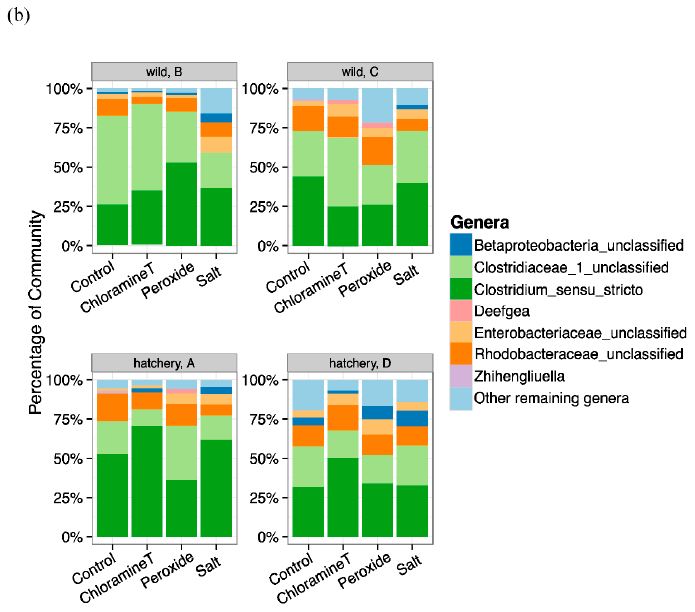
Figure 2. Taxonomic composition of bacterial communities identified from the lake sturgeon larval GI tracts ( a ) at the phyla level and ( b ) at the genera level. ( a ) Relative abundance (percentage) of dominant bacterial phyla found in the gut microbiota of lake sturgeon larvae separated based on sample family/group to display variation in communities across prophylactic treatments. Three predominant phyla were present in gut microbial communities ( Firmicutes , Proteobacteria , Actinobacteria ). The other phyla were characterized as Others; ( b ) relative abundance (percentage) of dominant bacterial taxa found in fish gut samples, separated by family/group and treatment. Among the most abundant taxa included Unclassified Betaproteobacteria , Unclassified Clostridiaceae_1 , Clostridium_sensu_stricto , and Unclassified Enterobacteriaceae